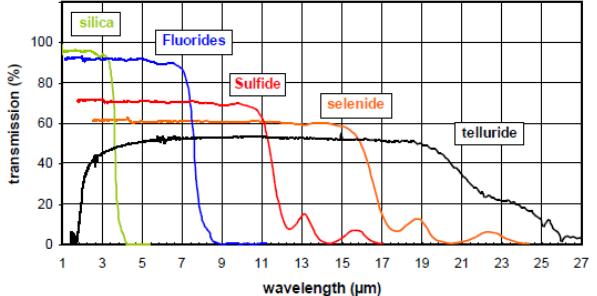
Figure 1. A comparison of the typical transmittance spectra of silica, fluorides, sulfide, selenide and telluride bulk